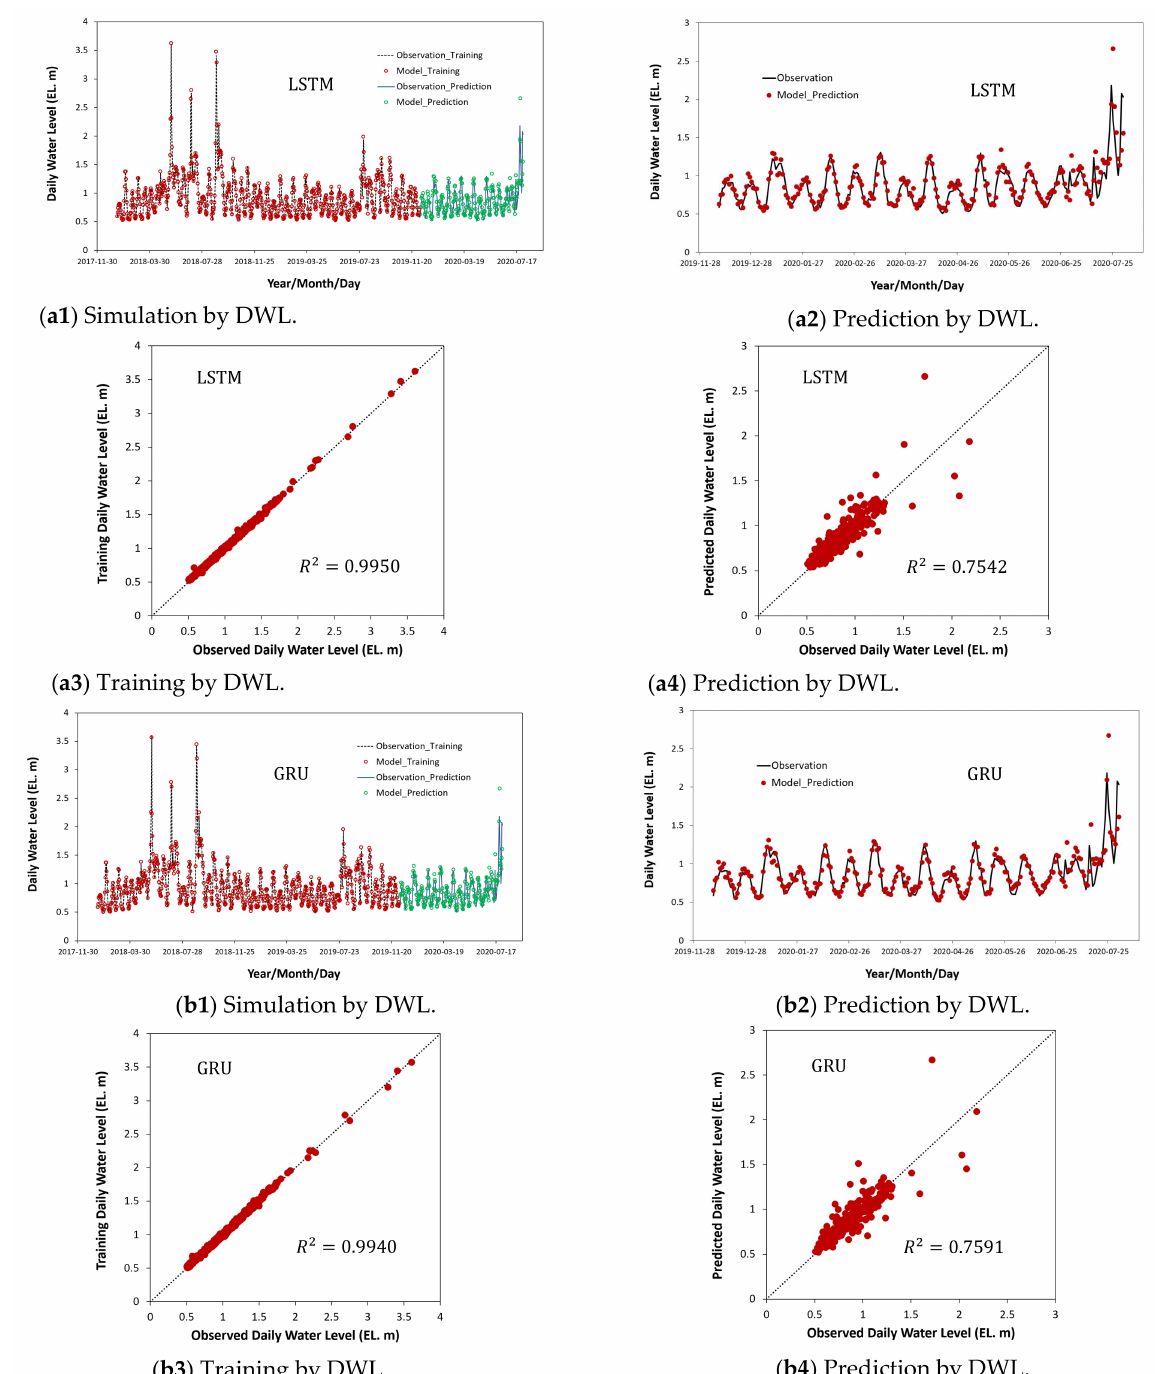
Figure 6. Observed and computed total time series water levels ( a1 ) and ( b1 ) as univariate input data, prediction ( a2 ) and ( b2 ) as univariate input data, R 2 for training ( a3 ) and ( b3 ), and R 2 for prediction ( a4 ) and ( b4 ): ( a1 – a4 ) Long Short-Term Memory (LSTM); and ( b1 – b4 ) Gated Recurrent Unit